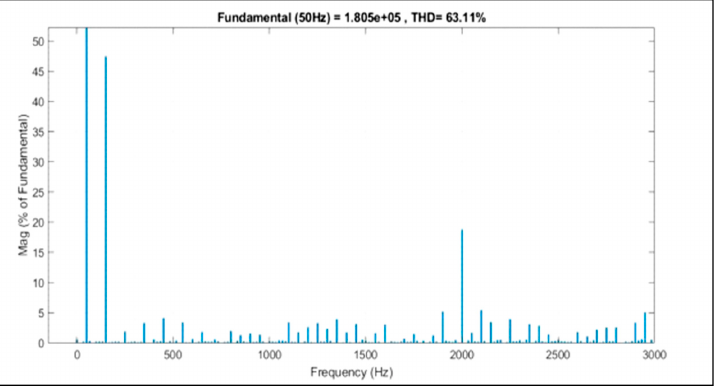
Figure 1. Voltage for a single AC side cascaded configuration including two H-bridges [26].